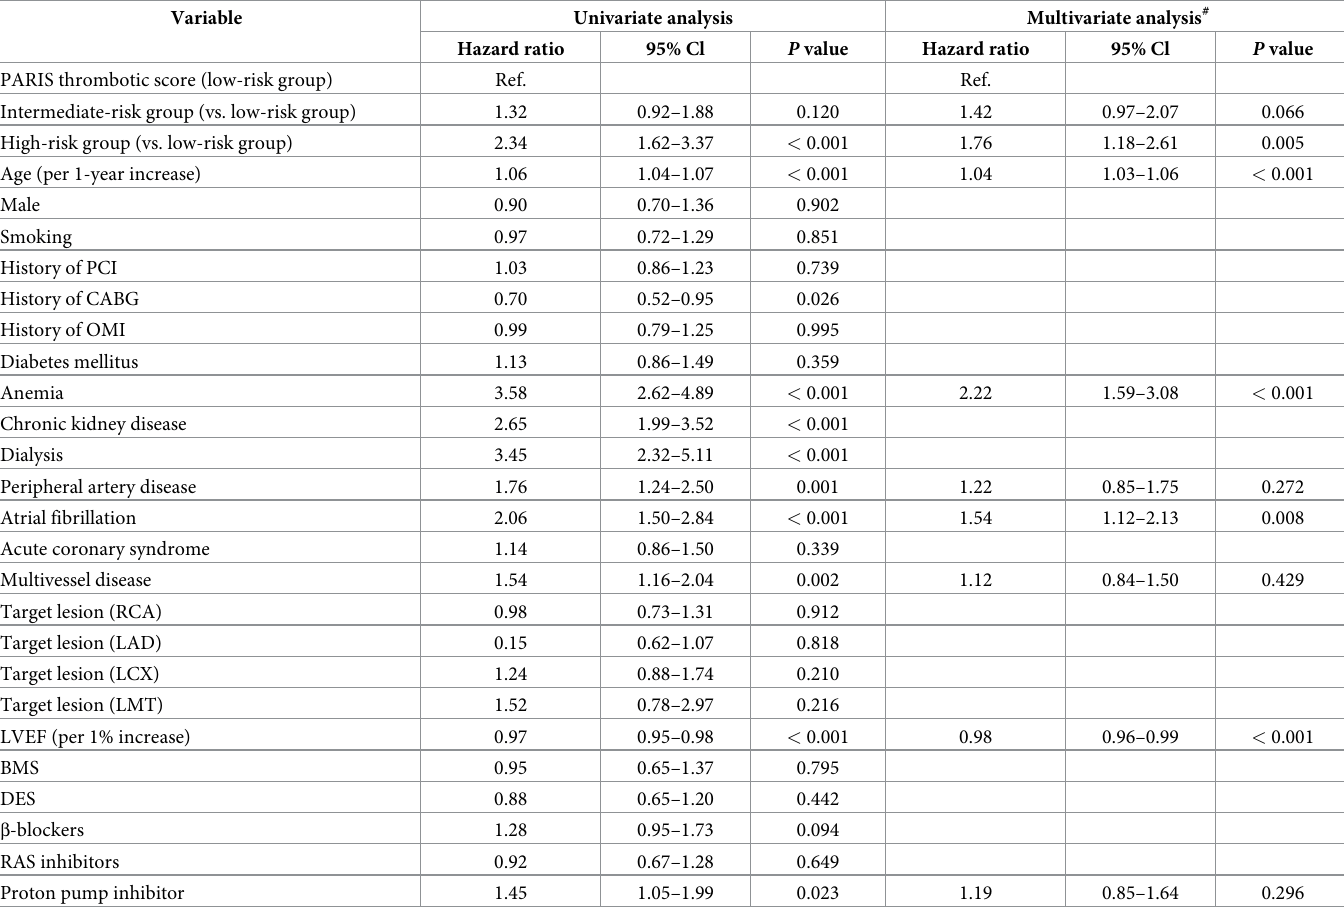
Table 2. Cox proportional hazard model of PARIS thrombotic score for all-cause